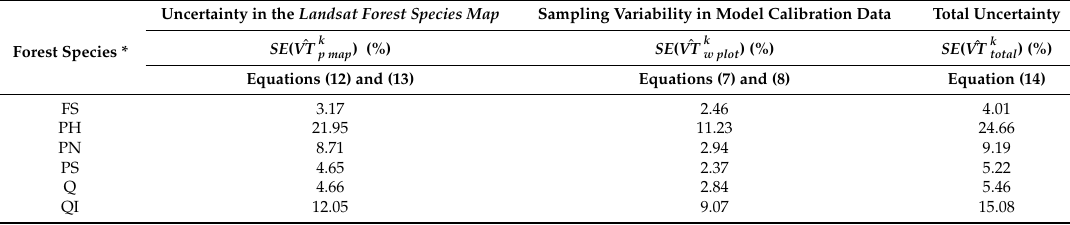
Table 6. Uncertainties in total volume estimates for the main forest species of La